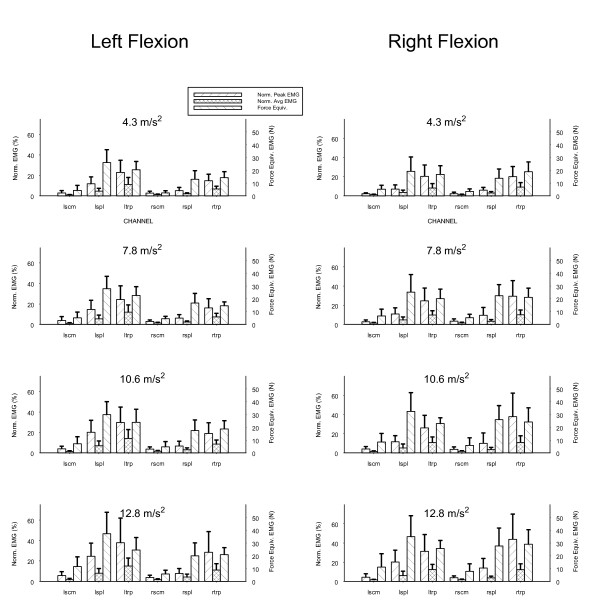
Trunk flexed to left and right. Normalized peak and average electromyogram (EMG) (percentage of isometric maximal voluntary contraction), force equivalent of EMG (N), and applied acceleration. LSCM, left sternocleidomastoid; RSCM, right sternocleidomastoid; LSPL, left splenius capitis; RSPL, right splenius capitis; LTRP, left trapezius; RTRP, right trapezius.